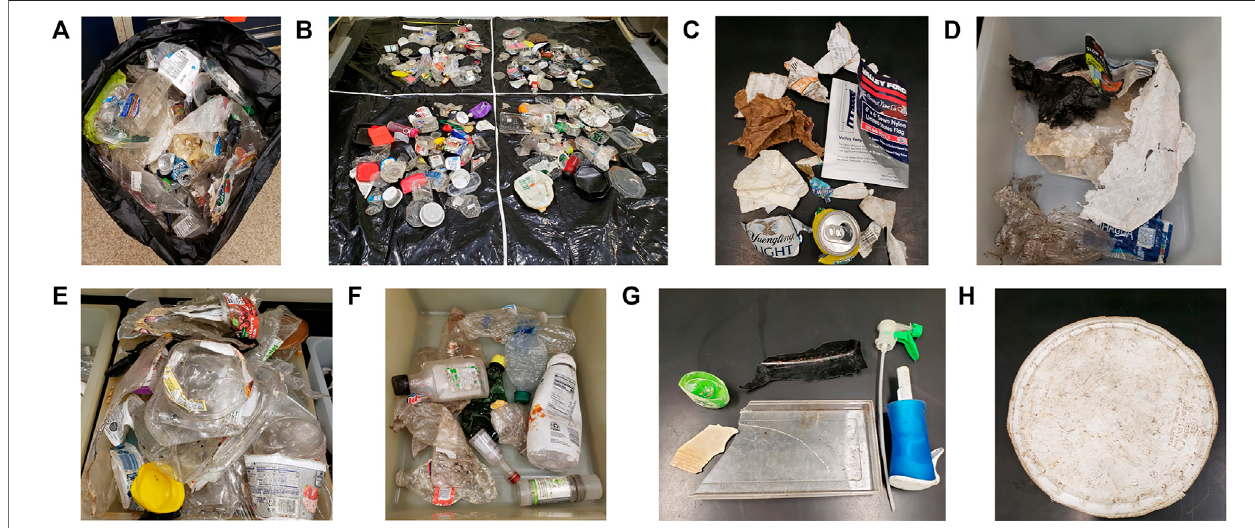
FIGURE 2 | Representative images of MSW during sampling and sorting. Plastic as received (A) and coned and quartered (B) . Plastic was sorted into non-plastic contaminants (C) , fi lms and baggies (D) , food containers (E) , bottles (F) , other (G) , and durable goods (H) .